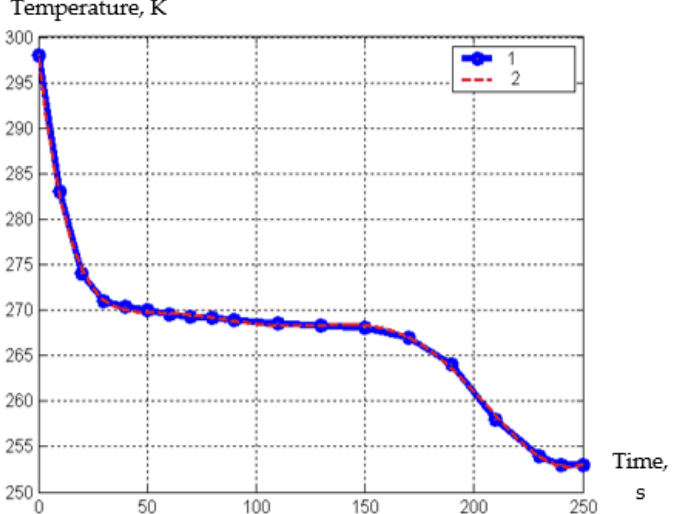
Figure 6. The temperature (K) dependence of the upper layer when freezing pieces of squash from time (s), to the time at a freezer temperature of − 25 °C; 1—experimental curve, 2—approximating curve. The time in the cascade freezer for our juicy fruits, berries, or chopped vegetables can be significantly reduced if other refrigerants are used instead of air. Therefore, we and in liquid nitrogen. The results of the study are presented in Figure 7.